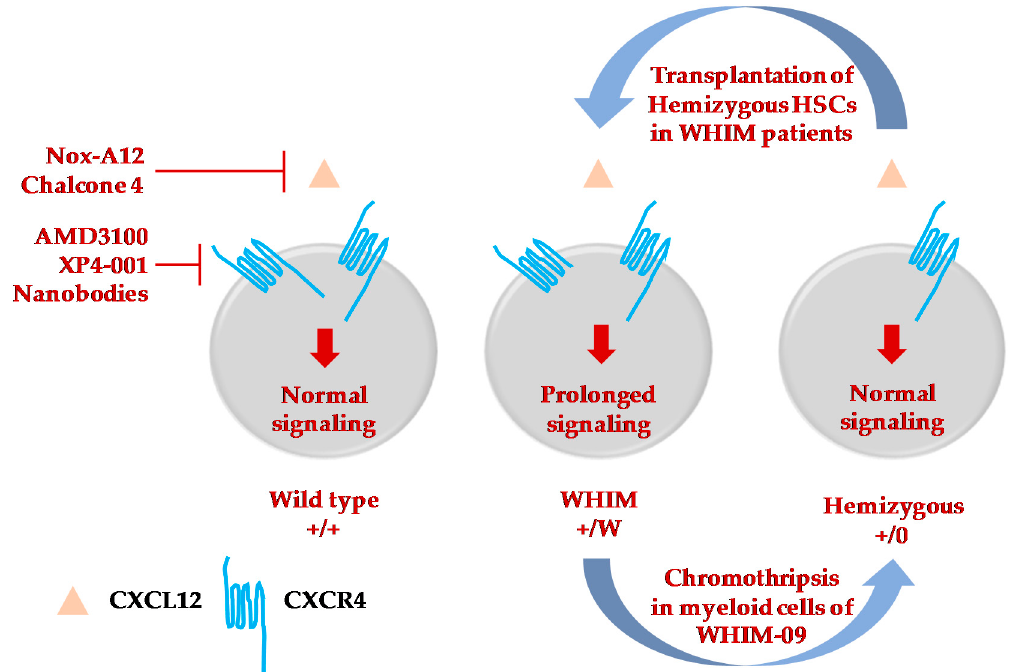
Figure 2. Therapeutic strategies to treat and cure WHIM syndrome. Selective inhibitors or molecules to specifically target either CXCL12 [102,103] or CXCR4 [38,43,44,101,104] have been developed and are at various phases of testing and clinical trials to mobilize immune cells from bone marrow of WHIM patients. Among the four patients to be cured of WHIM syndrome, three of them underwent successful hematopoietic stem cell transplantation [35,72,75]. The fourth patient, WHIM-09, was fortuitously cured by chromothripsis which occurred in a single HSC, which resulted in repopulation of myeloid but not lymphoid cells, cessation of recurrent bacterial infections and clearance of HPV-induced warts [15]. This suggested the possibility of inactivating the CXCR4 WHIM allele by gene editing and transplantating autologous edited CXCR4 -hemizygous HSCs as a possible cure for WHIM syndrome. Transplantation of Cxcr4 +/0 HSCs is successful in the reconstitution of blood cells in WHIM mice [34].